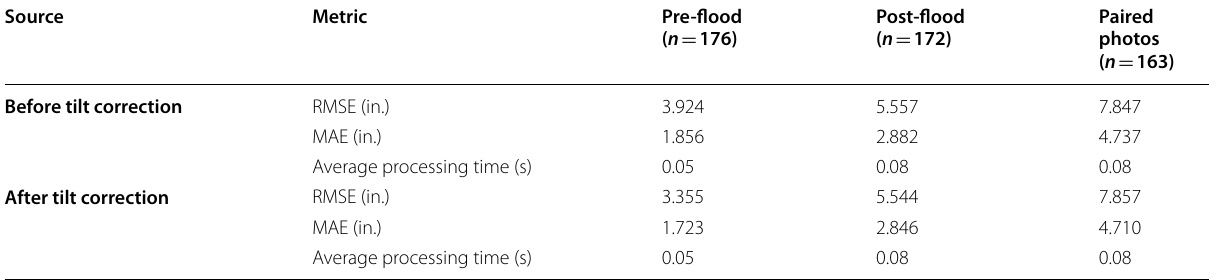
Table 4 Performance of the trained model in estimating pole lengths in pre- and post-flood photos of the test before and after tilt correction Source